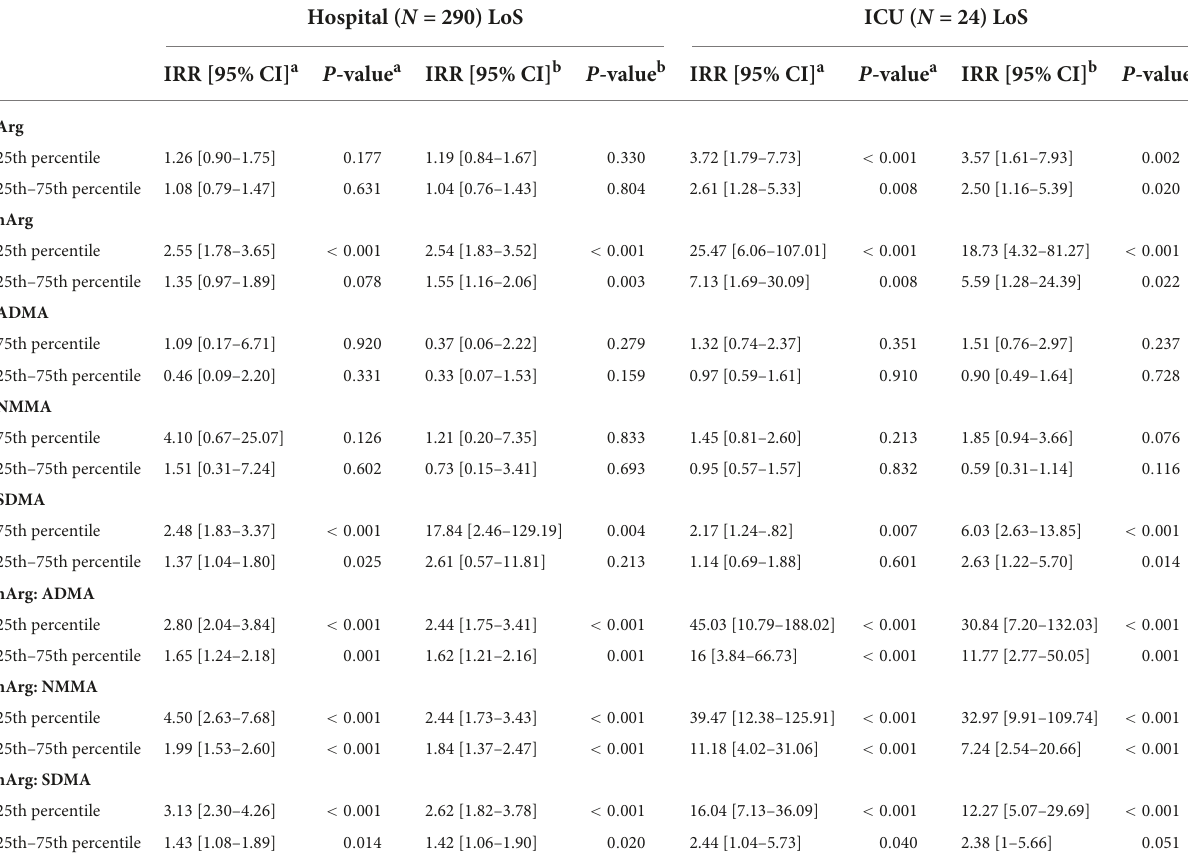
TABLE 3 Incidence rate ratio for hospital and intensive care unit (ICU) length of stay (LoS) stratified by percentiles of homoarginine (hArg), asymmetric dimethylarginine (ADMA), symmetric dimethylarginine (SDMA), and N-monomethylarginine